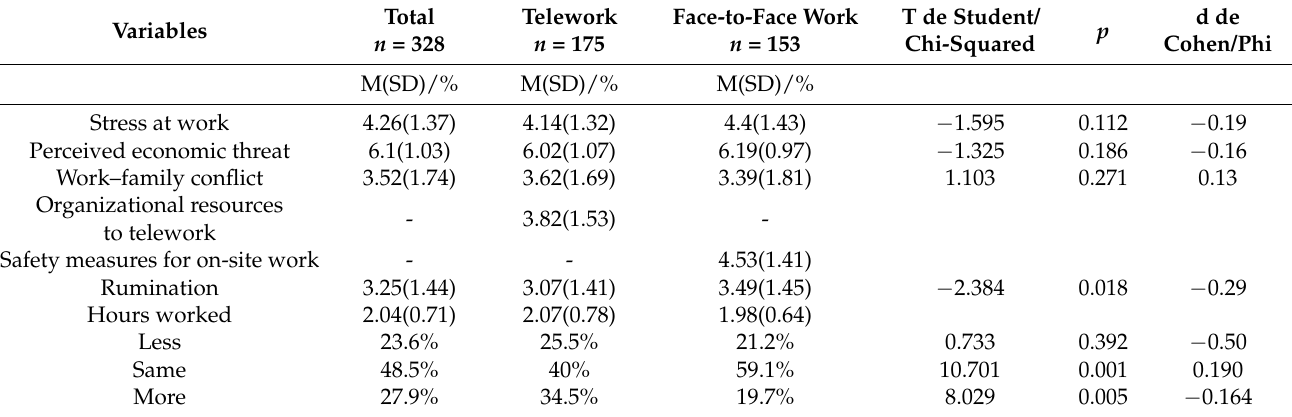
Table 1. Means, and T de Student and chi-squared test results according to work